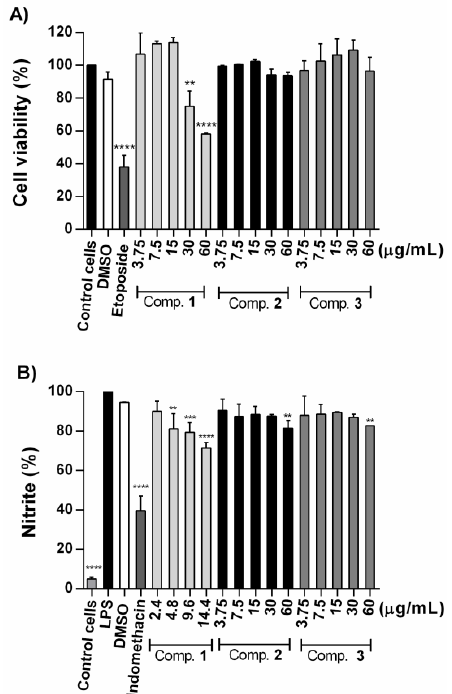
Figure 4. ( A ) Effect of Compounds 1 – 3 on cell viability of RAW 264.7 cells. Cells were incubated for